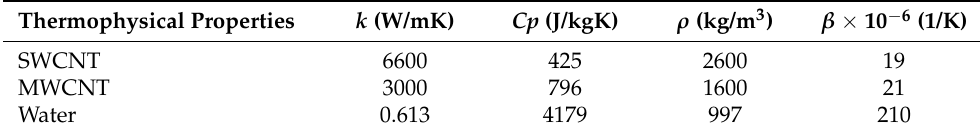
Table 1. Base fluid and nanoparticle numerical values for thermophysical properties